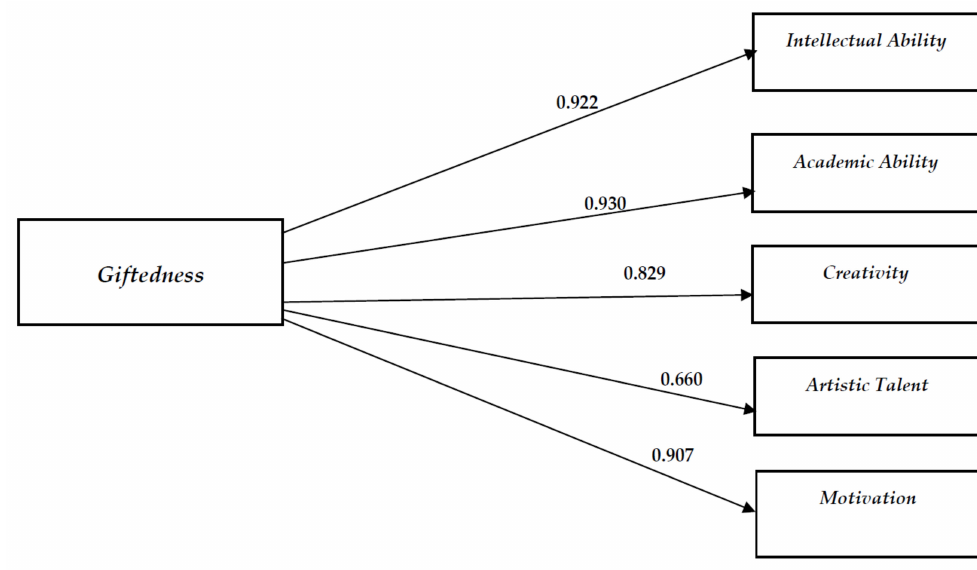
Figure 1. Structural model and standardized loadings for the GRS-P form.